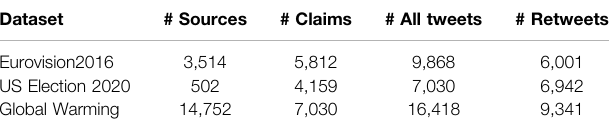
TABLE 1 | Basic statistics for three twitter